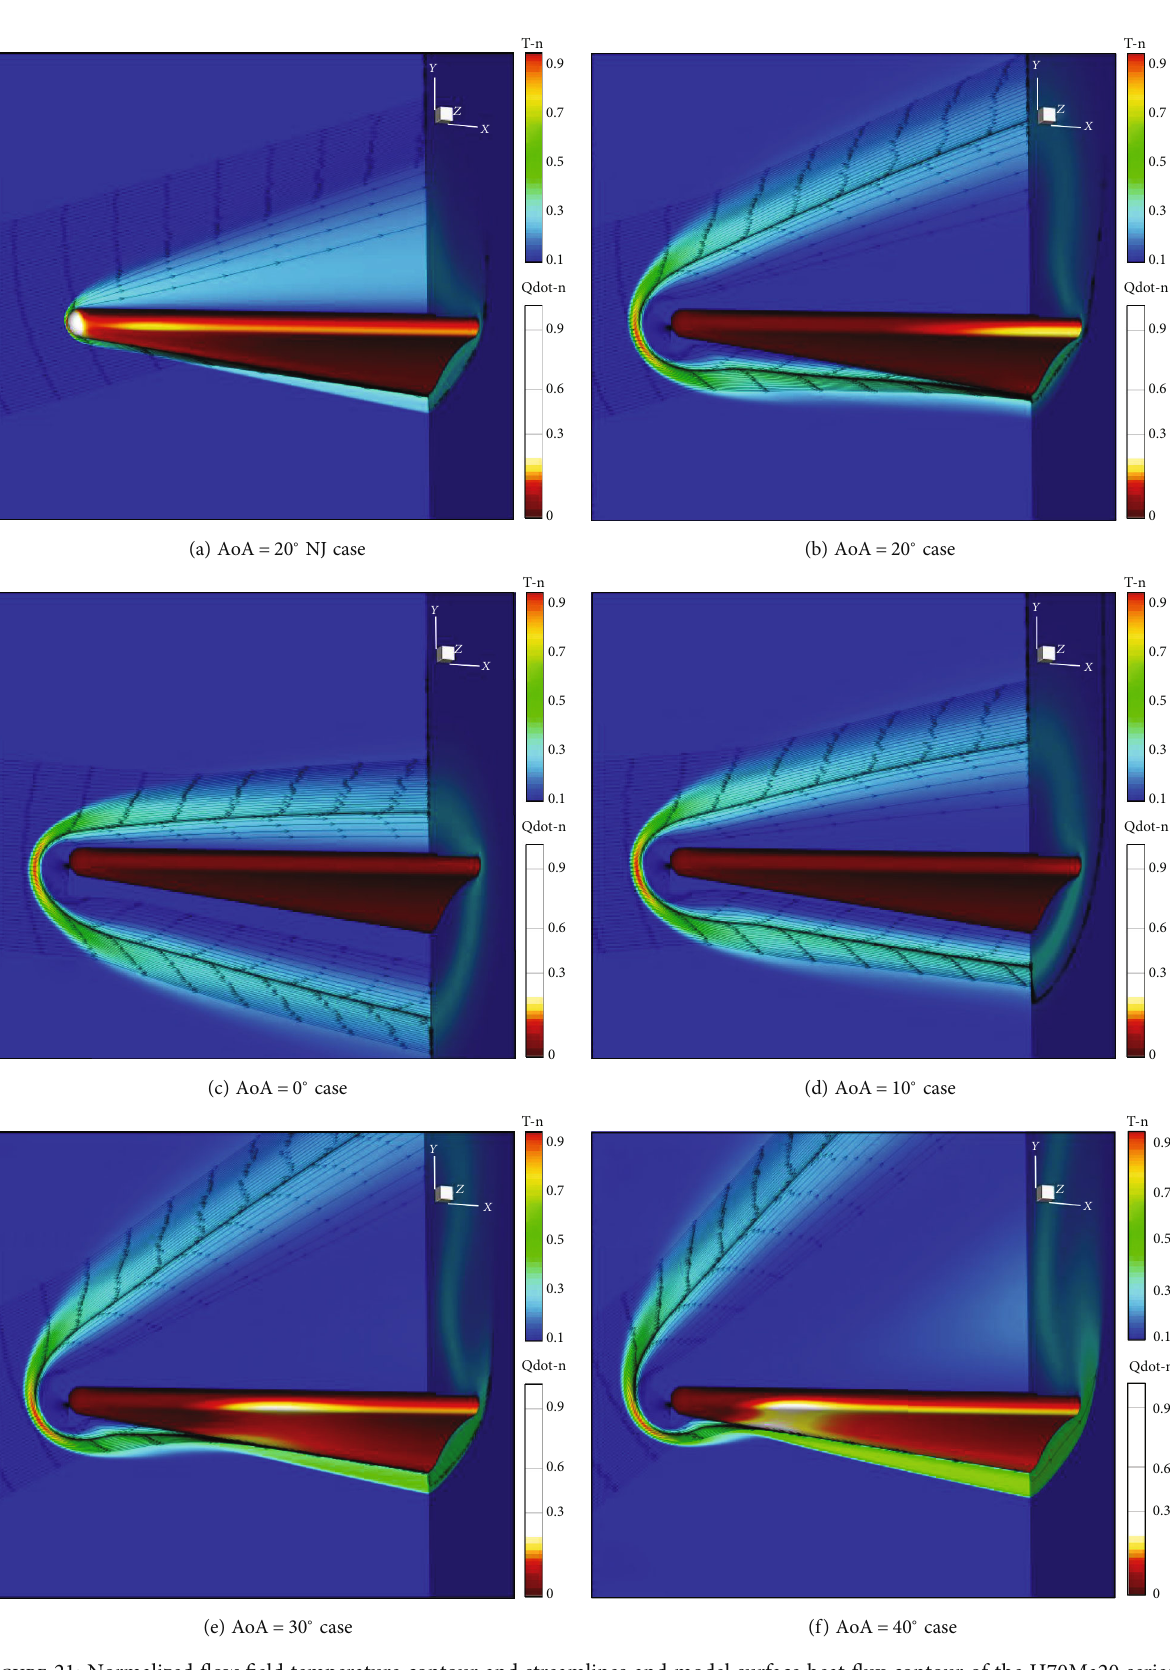
Figure 21: Normalized fl ow fi eld temperature contour and streamlines and model surface heat fl ux contour of the H70Ma20